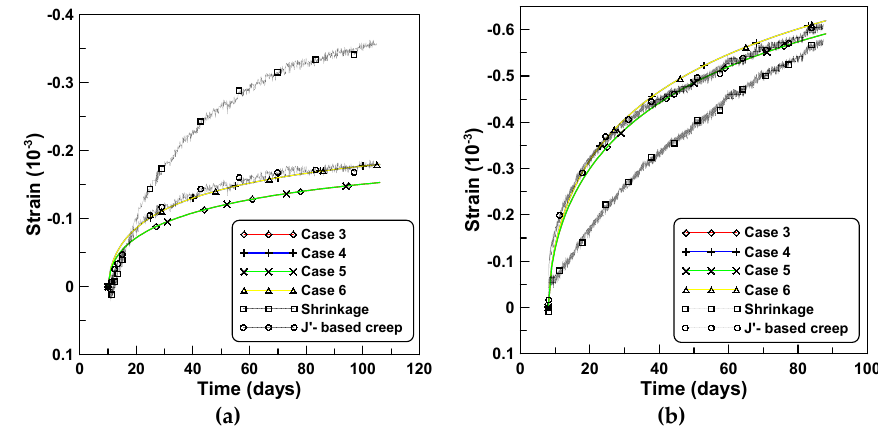
Figure 3. Shrinkage and creep strains elicited by different creep models under constant loads: ( a ) test series A and ( b ) test series